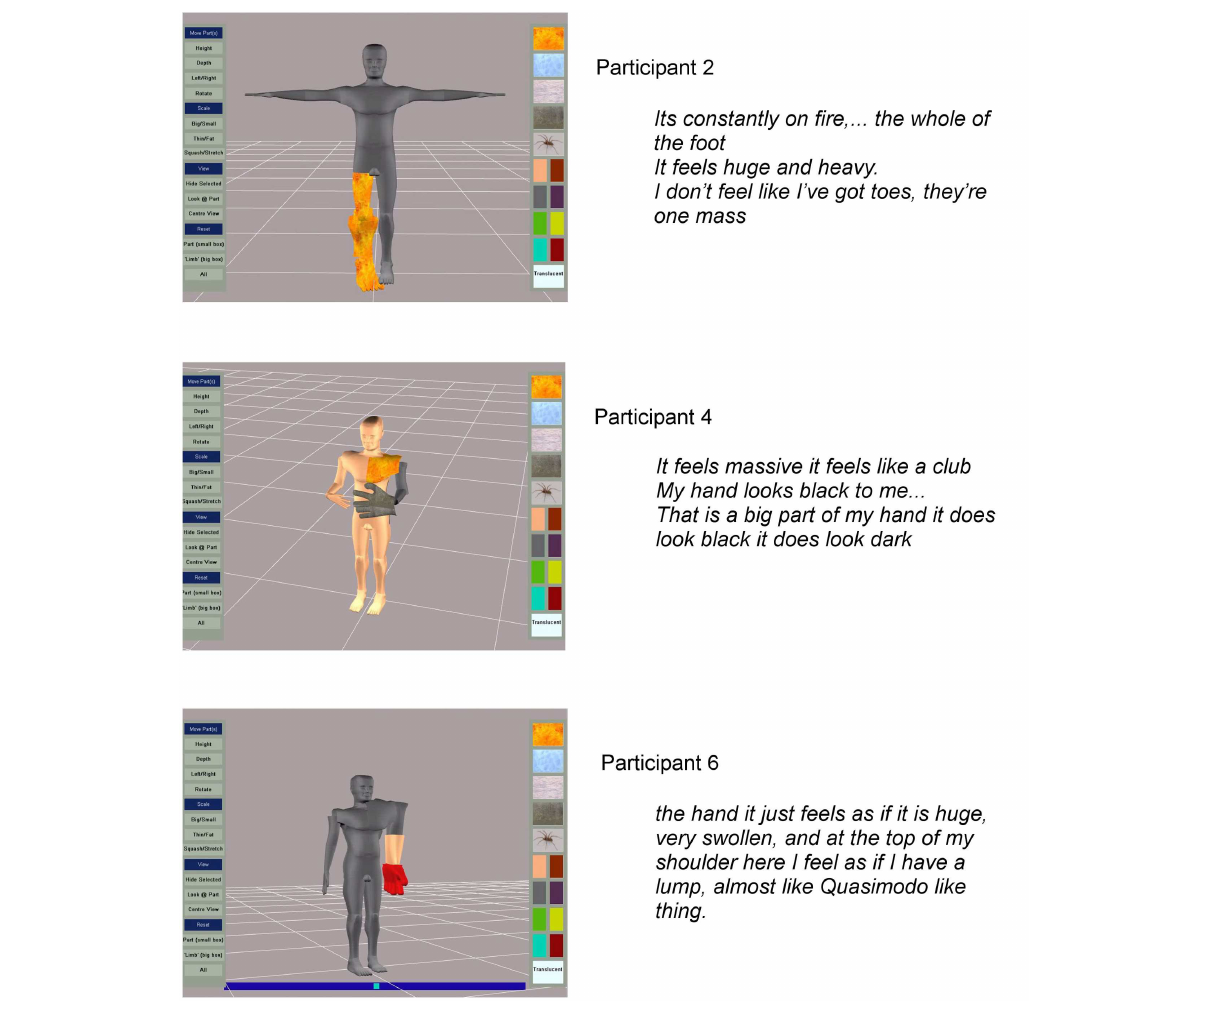
FIGURE 3 | Examples of images captured with participant’s verbal descriptions